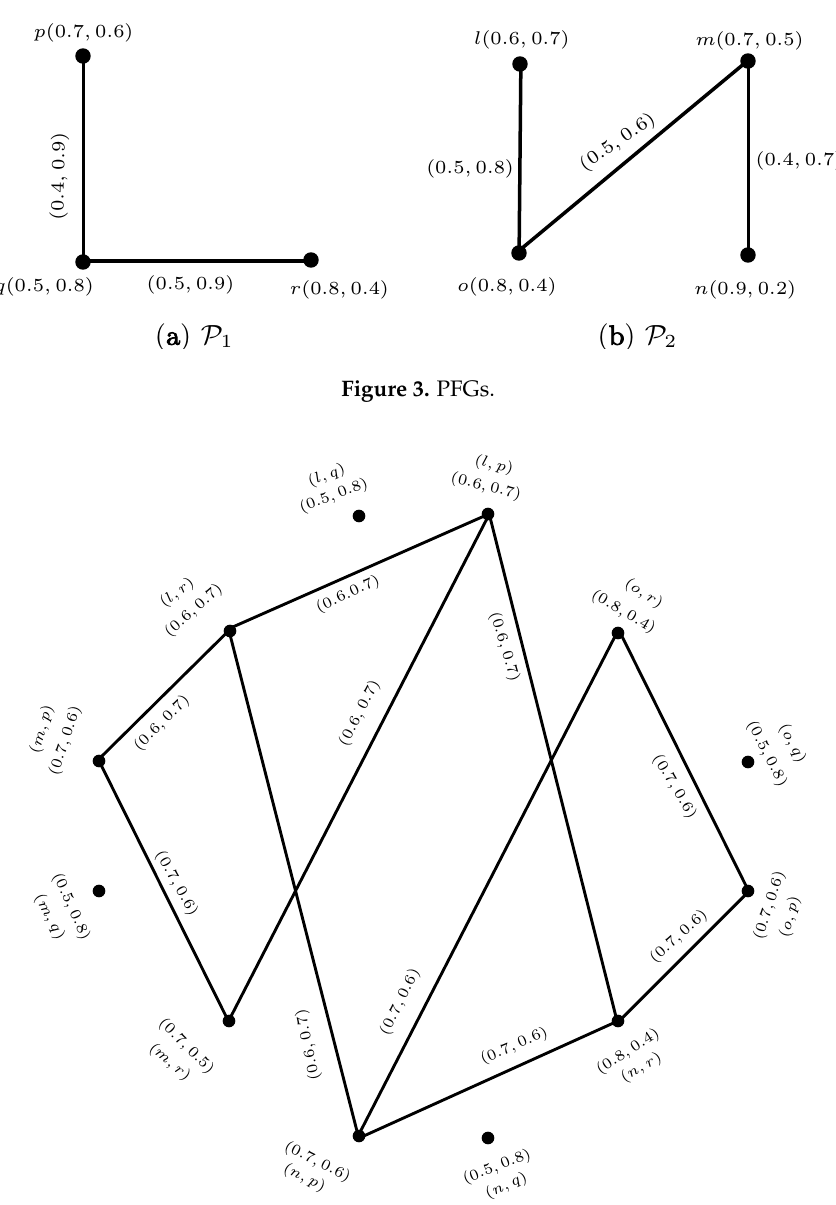
Figure 2.2: PFGs. Figure 3. PFGs.